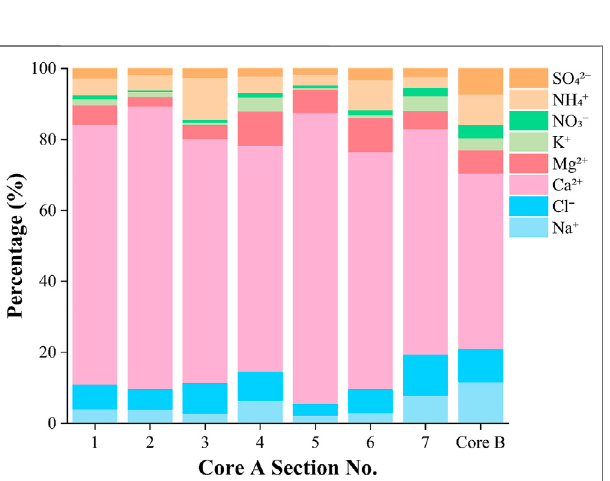
Frontiers in Earth Science |